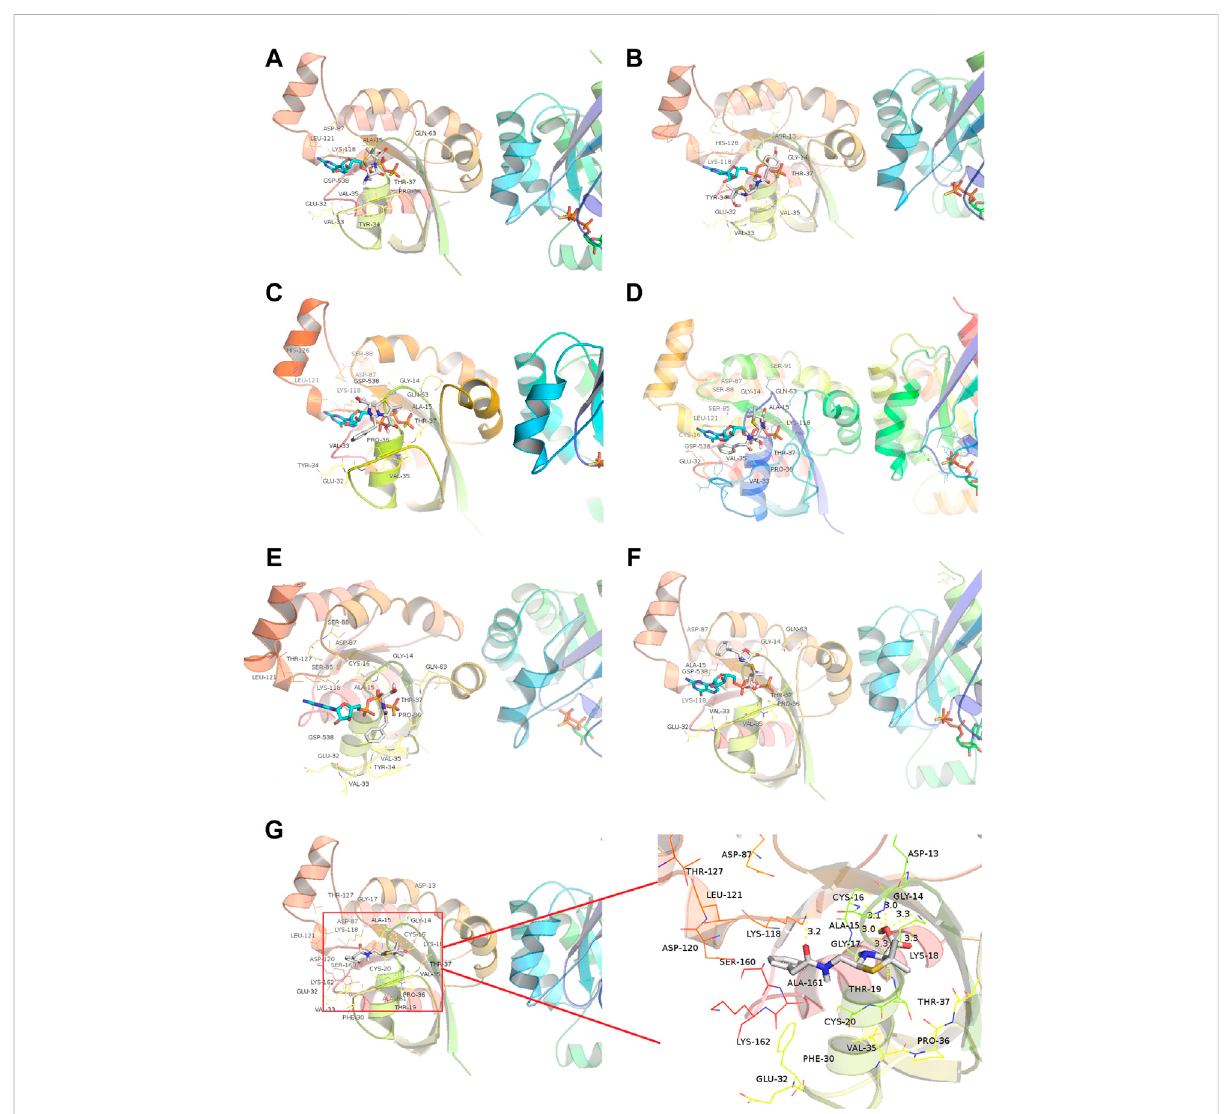
FIGURE 6 DockingofRhoA-GTP γ Swiththemainmetabolites/impuritiesofpenicillin. (A – F) SubstancesthatdidnotcauseNAHRs: (A) 6-aminopenicillanic acid, (B) penicillenic acid, (C) penillic acid, (D) penicilloic acid, (E) penamaldic acid, (F) penaldic acid; (G) penilloic acid, which can induce